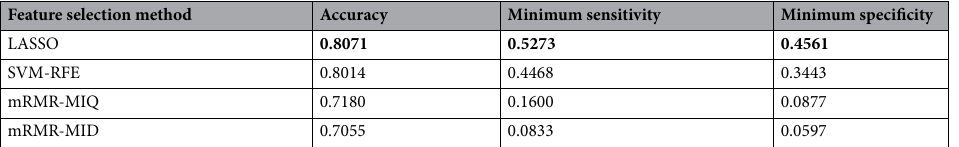
Table 6. Comparison of the proposed method with other feature selection methods in the test cohort in terms of classifier performance. The bold values indicate the highest score in each performance metric. LASSO least absolute shrinkage and selection operator, SVM-RFE support vector machine recursive feature elimination, mRMR-MIQ minimum-redundancy maximum-relevancy mutual information quotient, mRMR-MID minimum-redundancy maximum-relevancy mutual information